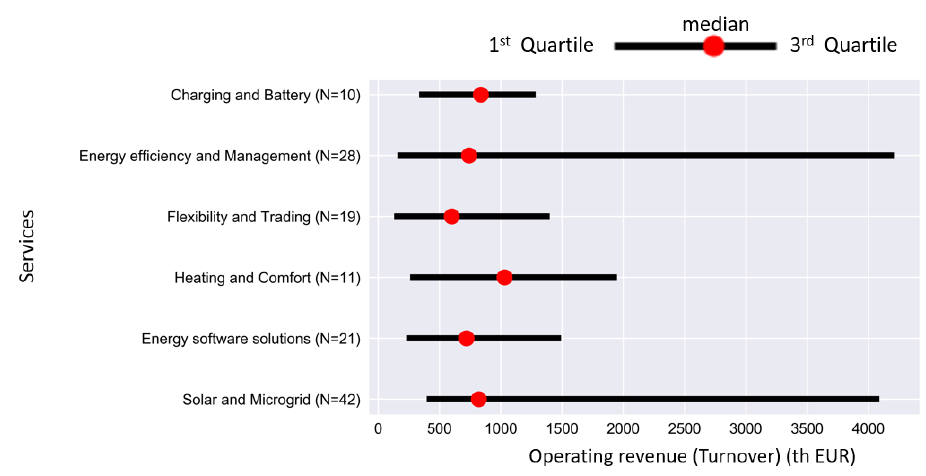
Figure 7. Operating revenue of startups in different service categories (N = number of startups).